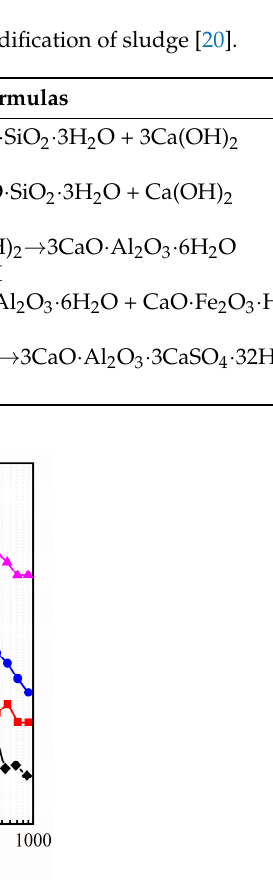
Figure 7. The water content of CDS versus curing age and FA content.